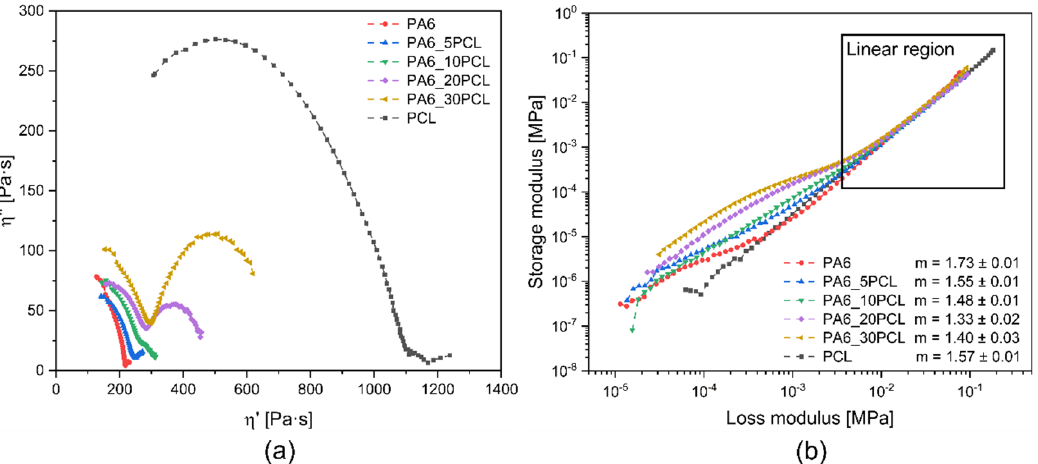
Figure 3. Rheological analysis of neat PA6, neat PCL, and their blends: ( a ) Cole–Cole plot and ( b ) Han plot.